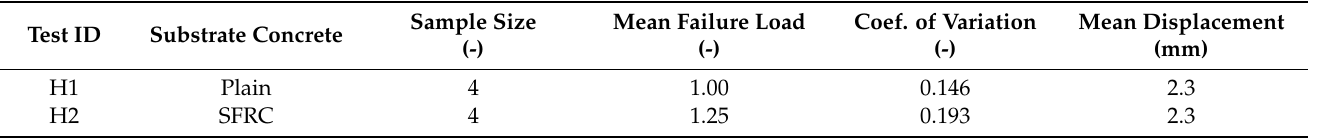
Table 3. Overview of pull-out test results normalized by H1 mean value as reference (standard installation in plain concrete).